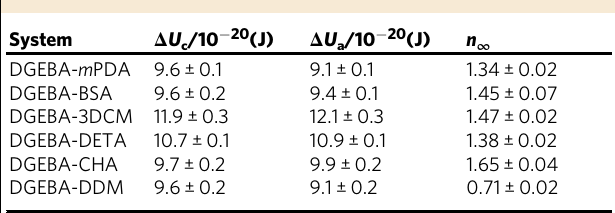
Fig. 8 Quantitative comparison with experimental data. Colored symbols are experimental data — taken from a ref. 34 , b ref. 51 , c – f ref. 52 — for the kinetics of diglycidyl ether of bisphenol-A (DGEBA) reacted at different temperatures with different amines (1,3-phenylenediamine ( m PDA), 4-4 ′ (1,3-phenylene- diisopropylidene) bisaniline (BSA), 4,4 ′ -diamino-3,3 ′ -dimethyldicyclohexylmethane (3DCM), diethylenetriamine (DETA), cyclohexylamine (CHA), 4,4 ′ - diaminodiphenylmethane (DDM)). Each curve corresponds to a different T of reaction. The red lines are obtained by fi tting the data at all temperatures (cid:1) (cid:3) ¼ A e (cid:2) β Δ U c þ B e (cid:2) β Δ U a p simultaneously using d p /d t = (1/ k chem + 1/ k diff ) − 1 (1 − p ) 2 , where k 1 (cid:2) p chem